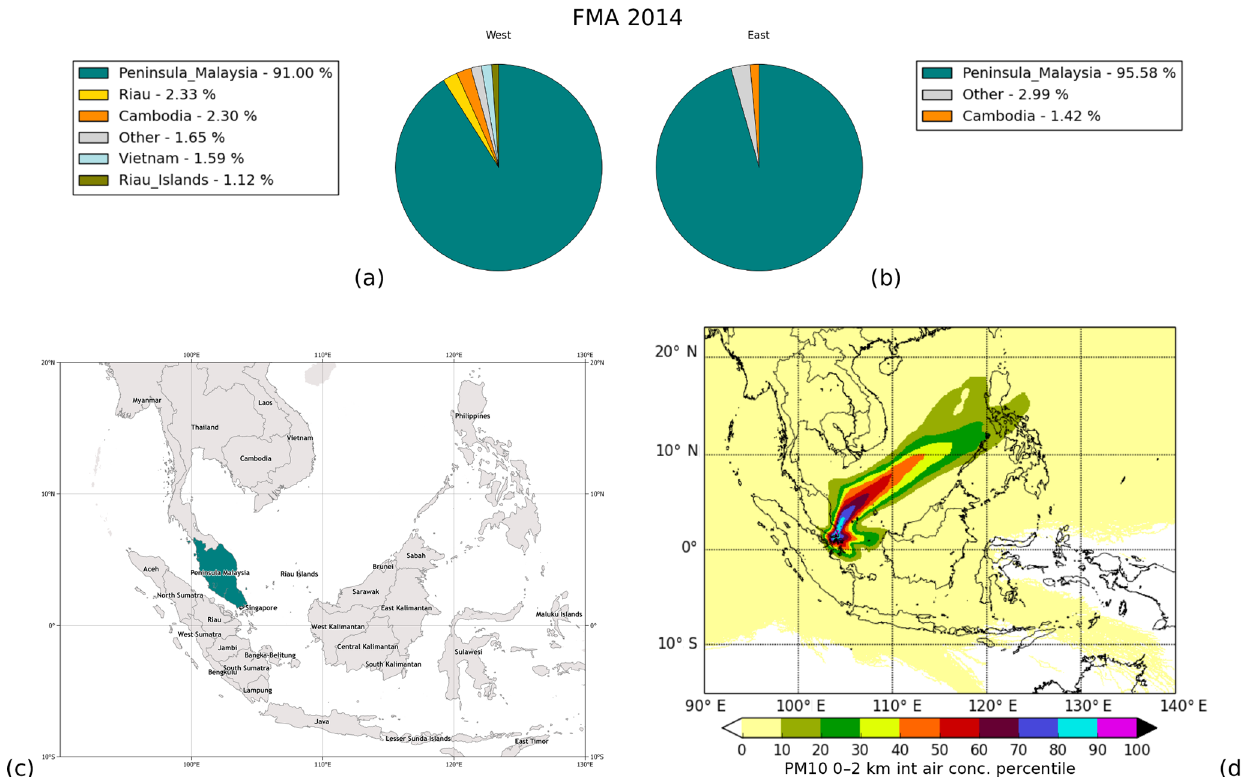
Figure 6. This figure shows results for PM 10 for FMA 2014: pie charts for the western (NTU) (a) and eastern (TP) (b) monitoring stations showing major contributing source regions, (c) the regional map highlighting only the major contributing source region, and (d) the air history map showing where the air arriving in Singapore originated from in FMA 2014. The “Other” category in the pie charts is from sources which individually contribute less than